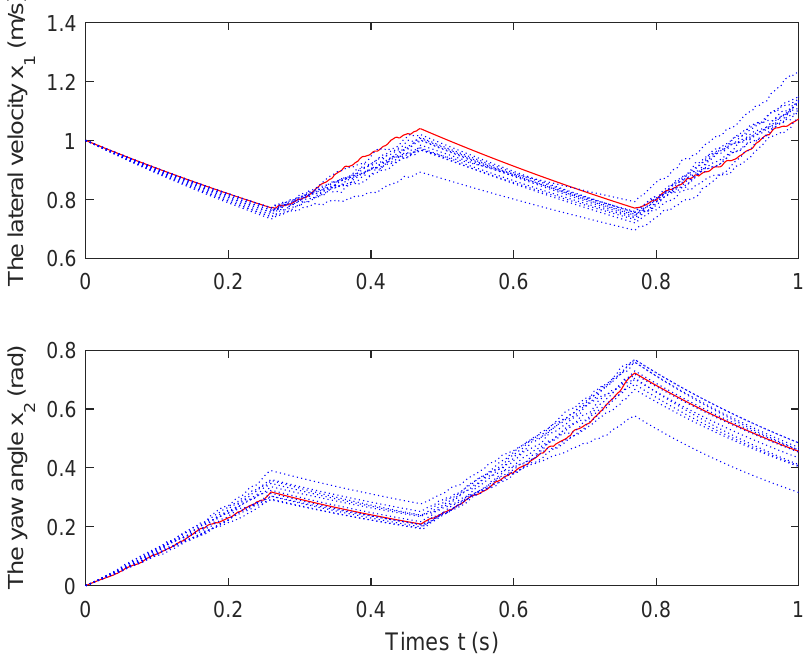
Figure 4. The trajectories of states x 1 ( t ) and x 2 ( t ) . The blue dotted lines explain the state trajectories with the iterate progress switching time vector τ ( k ) . As a comparison, the red solid line explains the optimal trajectories with respect to the optimal switching time